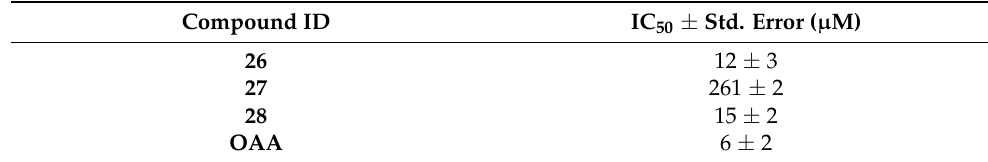
Figure 11. Identification of highly active tert . butyl esters 26 and 28 . Table 8. N -( o -, m - or p -carboxy-phenyl) oxalamic acid tert. butyl esters. Data fit with GRAPHPAD PRISM 5. Standard error of the fit given in µ M. IC 50 diagrams, including the fit and standard deviations of the individual experiments ( n = 3), are depicted in the Supplementary Materials.